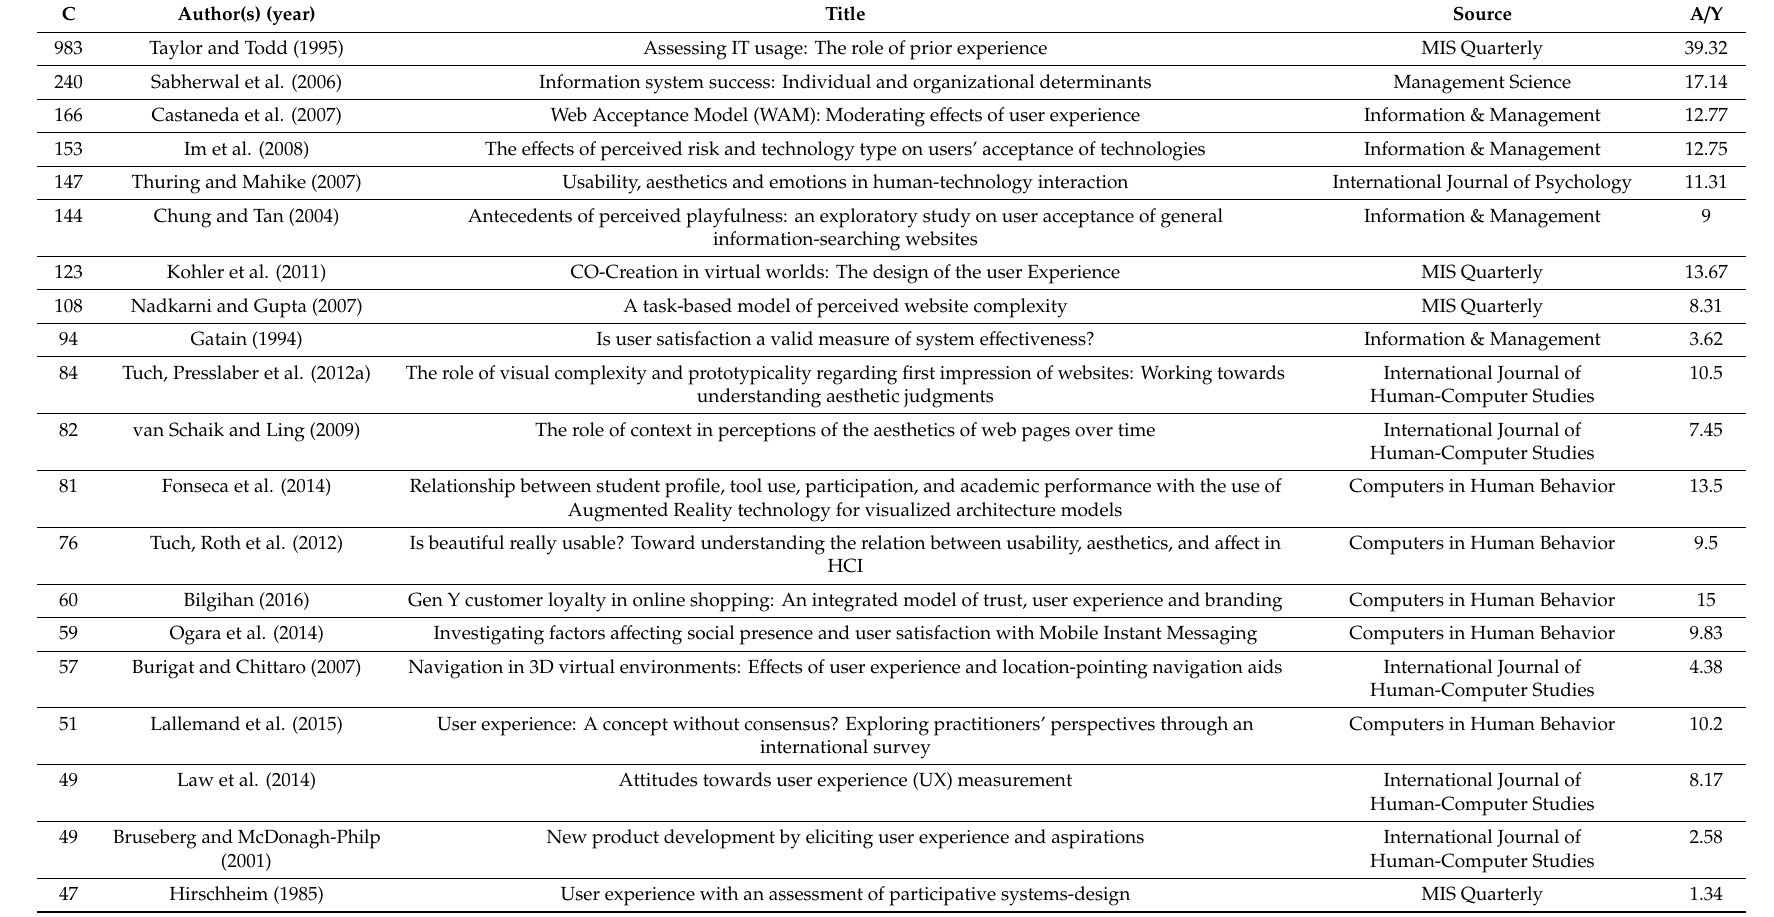
Table 7. The 20 most cited articles. Source: Own elaboration based on